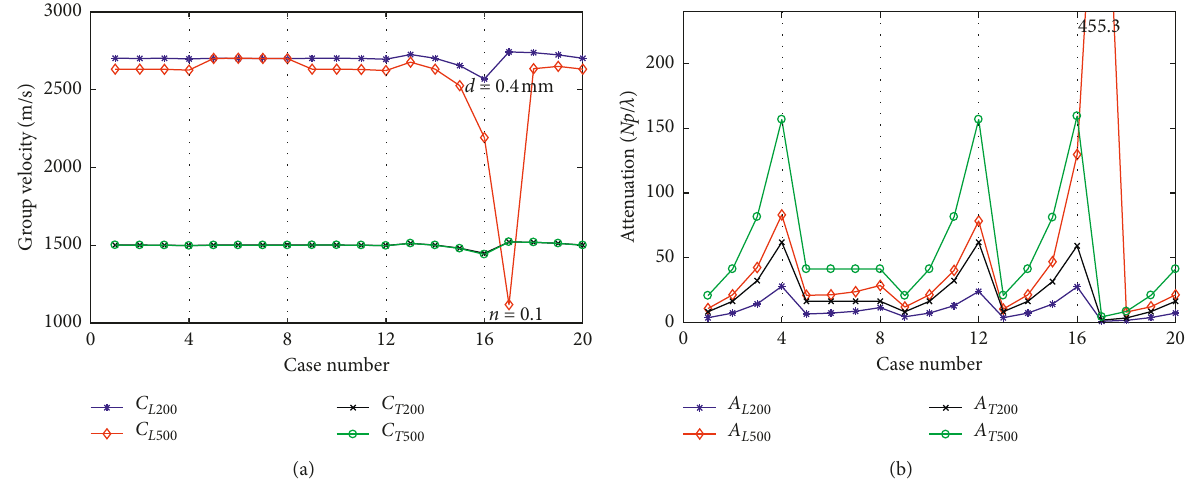
Figure 9: Comparison of dispersion characteristics of guided wave. (a) Comparison of group velocity. (b) Comparison of attenuation.